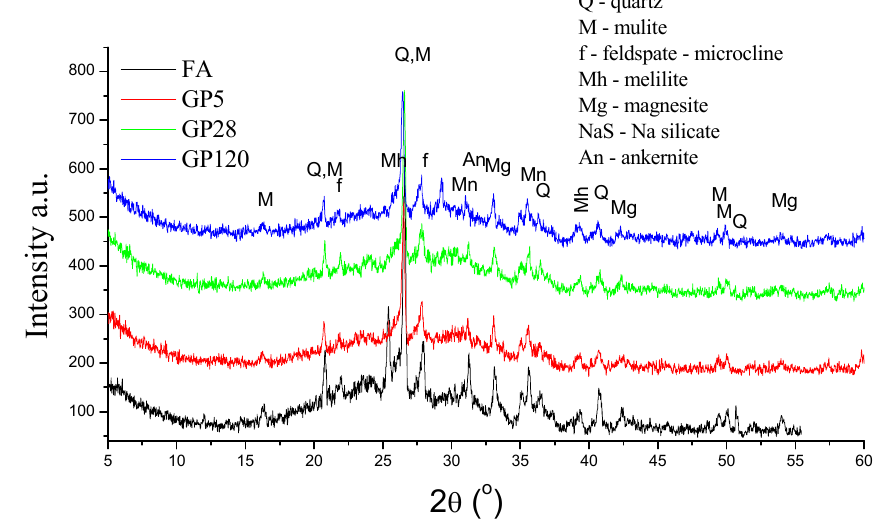
Figure 3 . XRD diffractograms of FA and GPs . Figure 3. XRD diffractograms of FA and